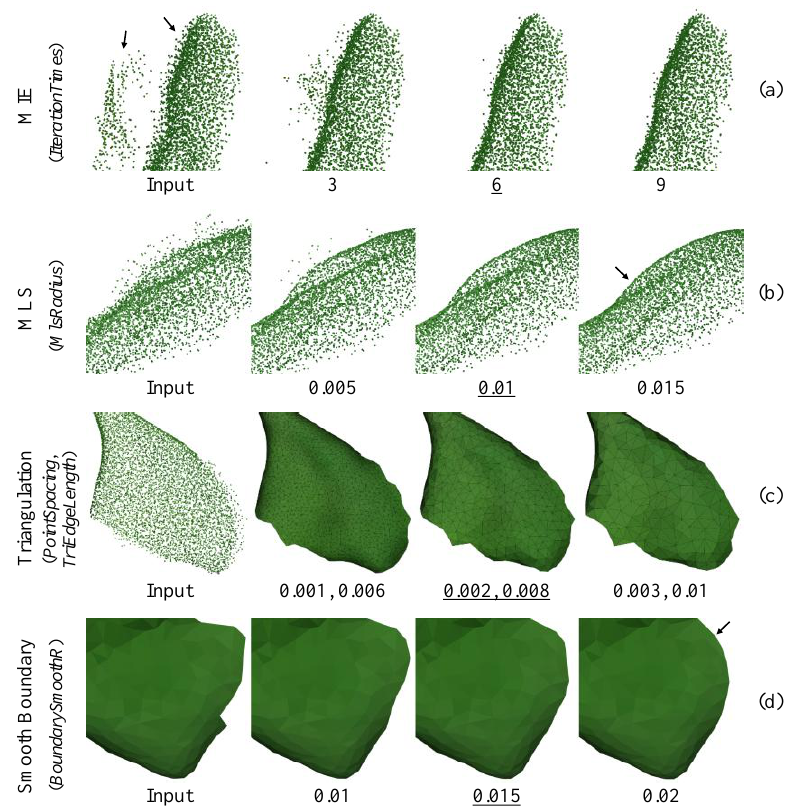
Figure 5. Key parameter optimization for major algorithms. In each row ( a – d ), the left title is the algorithm name with its key parameter(s) in parentheses, then follows the input data and the results under three different settings, where the optimized values are underlined. Arrows indicate the discussed key areas. All numbers are in meters except for IterationTimes .